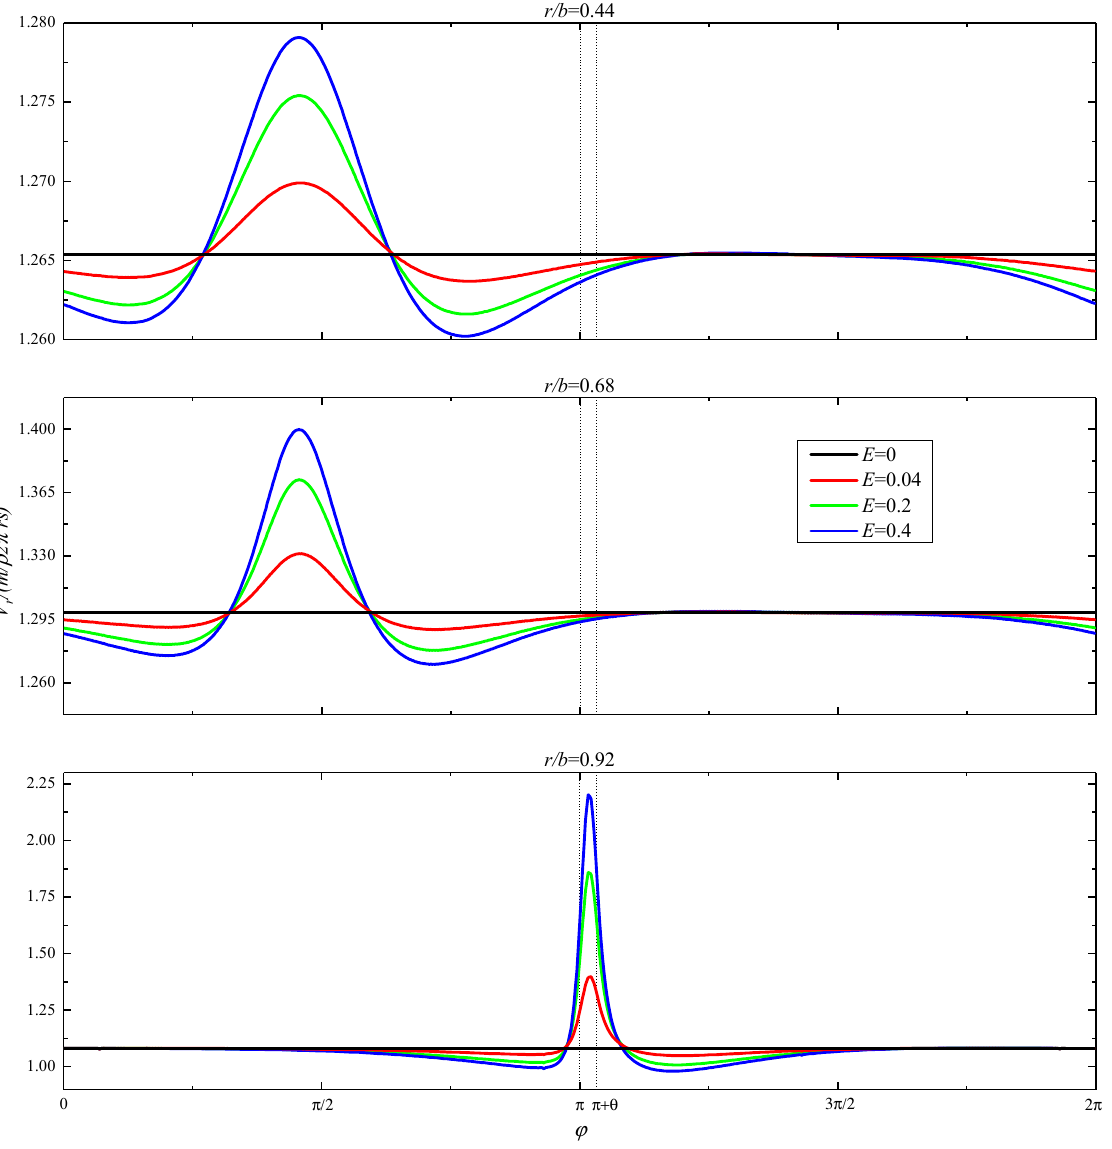
= 10,137 , (cid:1844)(cid:1857) = 5.12 × 10 (cid:2873) , (cid:2016) = 0.1 at z / s = 0.5. Figure 11. Dimensionless radial velocity for C w = 10,137, Re ϕ = 5.12 × 10 5 , θ = 0.1 at z / s = 0.5. Figure 11. Dimensionless radial velocity for (cid:1829) (cid:3050) (cid:3101) As the θ increases, the distribution of radial velocities becomes increasingly asymmetri- cal, with the downstream gradually taking the lead in the emergence of recirculation zones (as shown in Figure 12). In addition, the minimum values in the downstream areas decrease by a larger amount relative to θ = 0 than those in the upstream areas. (This phenomenon becomes more pronounced as the θ increases, as θ = 0.4 and r / b = 0.92). This is mainly due to the different magnitudes of the radial coriolis force on the upstream and downstream areas. When θ (cid:54) = 0 (turbine blade fracture), the tangential velocities on either side of the low-pressure zone are in opposite directions, and the fluid in the upstream areas is subject to a smaller radial inward coriolis force, while the fluid in the downstream areas is subject to a larger force, so the radial velocity in the downstream areas is smaller and more prone to backflow. This phenomenon is more pronounced at a larger θ , where the difference in tangential velocity between the two sides of the low-pressure zone is greater, and therefore the effect of the coriolis force is more pronounced. This means that when a turbine blade fractures, the downstream area at the high-radius location is more affected, in terms of radial